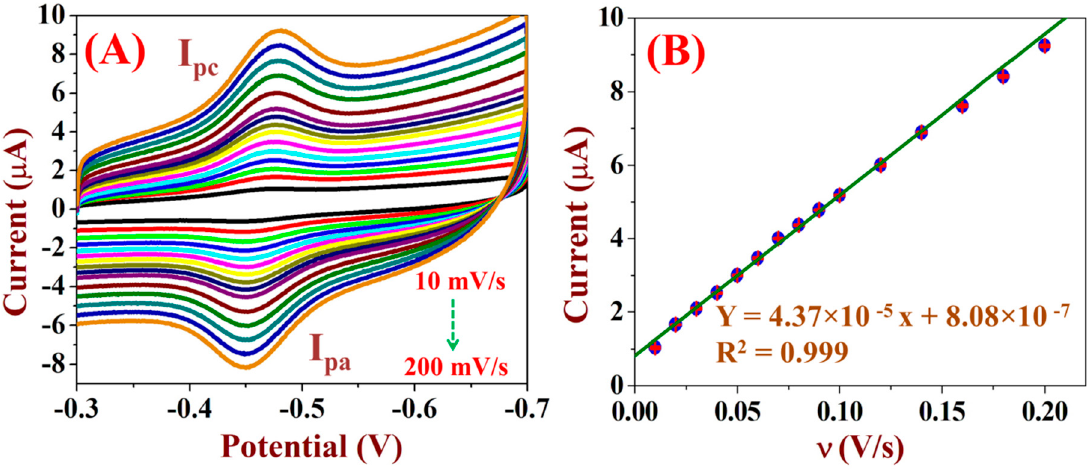
Figure 7. ( A ) CVs were recorded using FAD/Ti 3 C 2 T x /GCE in 0.1 M PBS at different scan rates from 0.01 to 0.2 V/s. ( B ) The linear plot was made between the scan rates and the reduction peak currents.